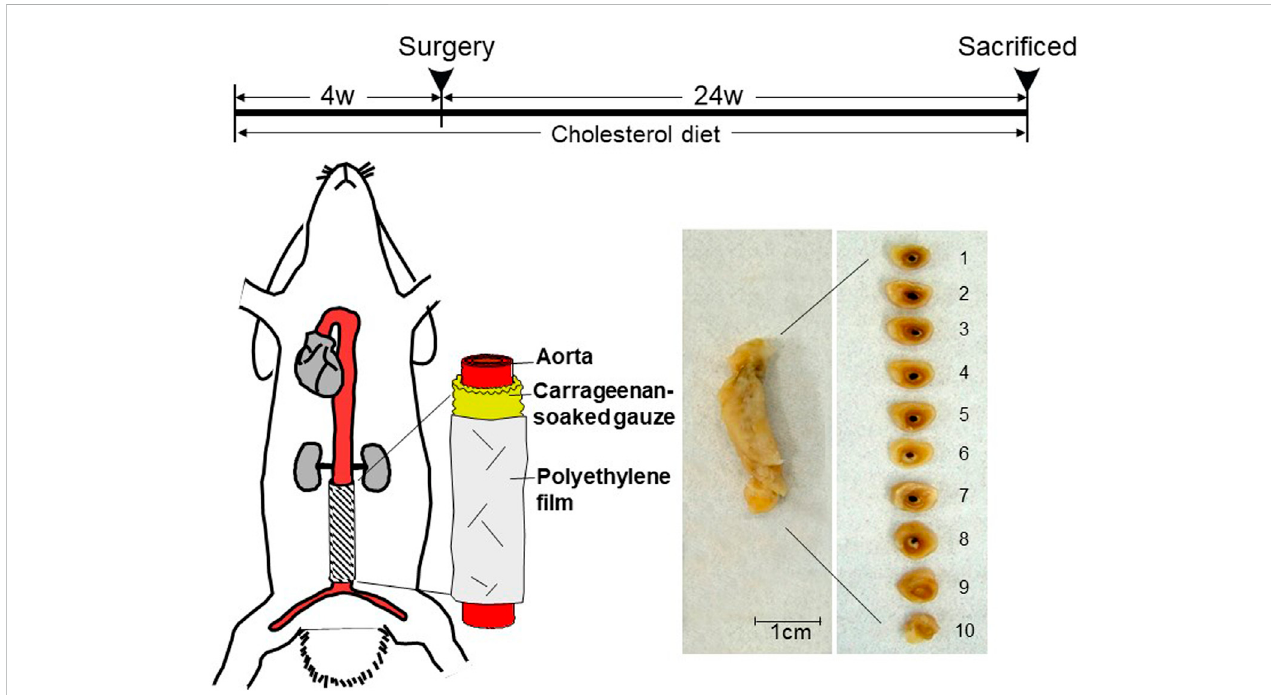
FIGURE 1 Schematic illustration of carrageenan-induced abdominal aortic lesions. Rabbits were fed a cholesterol-diet for 4 weeks before the surgery. A piece of sterilized gauze pre-soaked with λ -carrageenan was placed along the isolated abdominal aorta between the inferior mesenteric artery and lumbar artery and wrapped with a piece of polyethylene fi lm. At the end of experiments, aortic rings were sectioned as shown on the right. The abdominal aorta was cut into 10